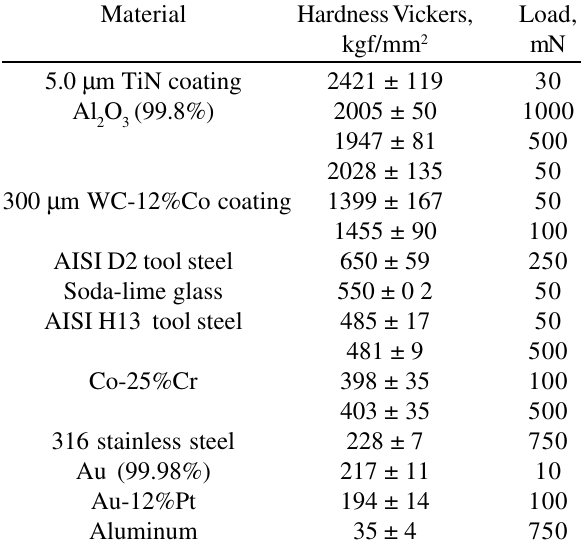
Table 6. Hardness Vickers determined experimentally using dif- ferent loading, for materials of different elastic-plastic